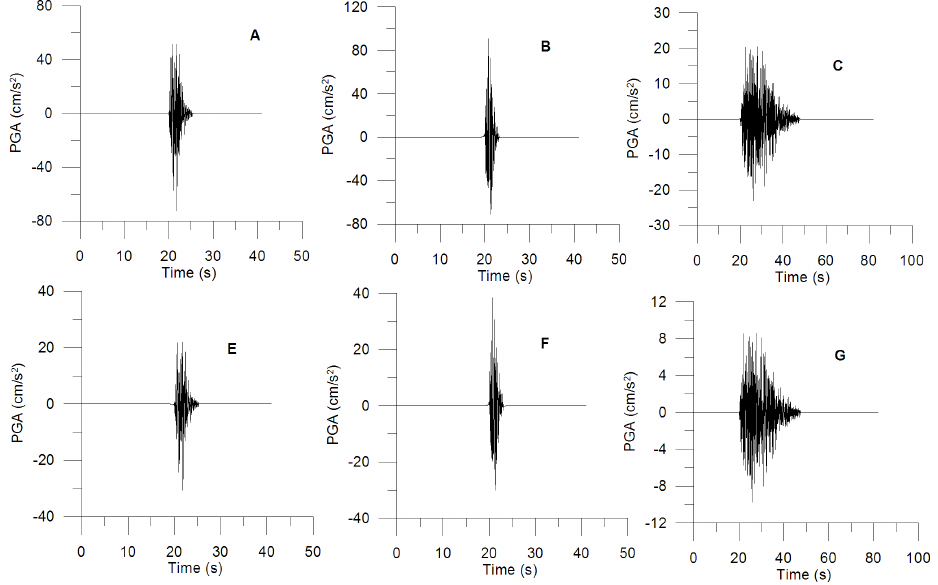
Fig. 9. Panels A , B , and C are the simulated PGA predicted from seismogenic zones 1, 2 ,and 3 at the highest amplification site (site 2), respectively. Panels E , F , and G are the simulated PGA predicted from the seismogenic zones 1, 2 and 3 at the lowest amplification site (site 13).